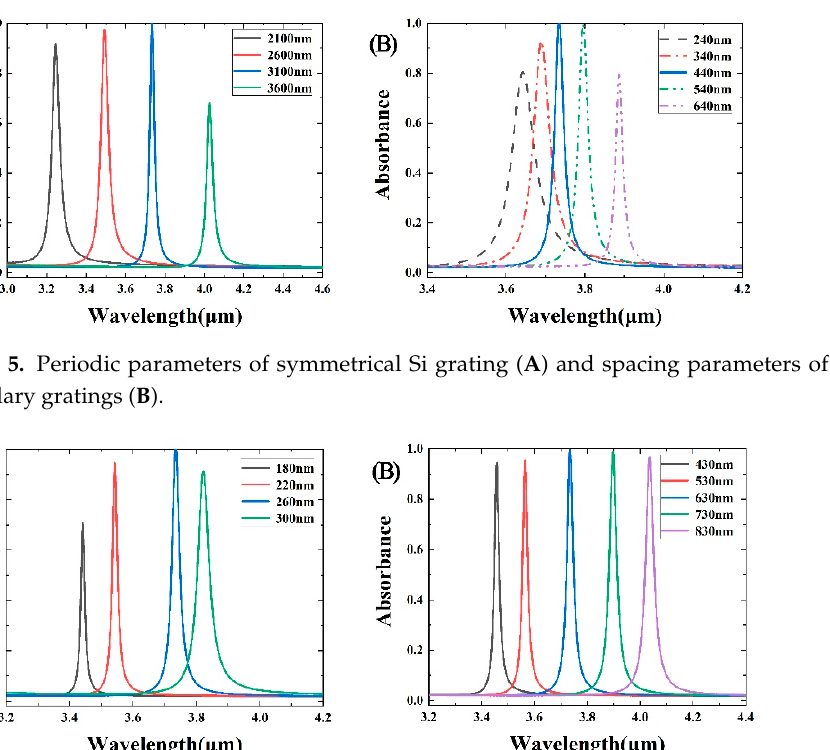
Figure 5. Periodic parameters of symmetrical Si grating ( A ) and spacing parameters of the two secondary gratings ( B ).